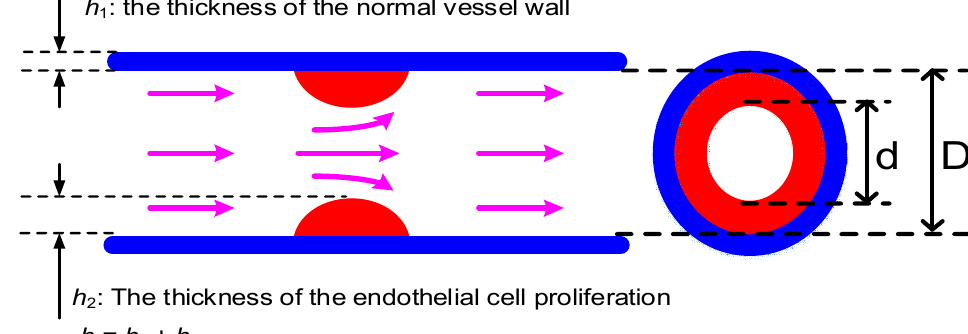
Figure 3. The definition of degree of stenosis (DOS), which is defined as the ratio of the stenosis to non-stenosis areas, where h 1 and h 2 denote the wall thicknesses of normal vessel and the vessel with endothelia cell proliferation.